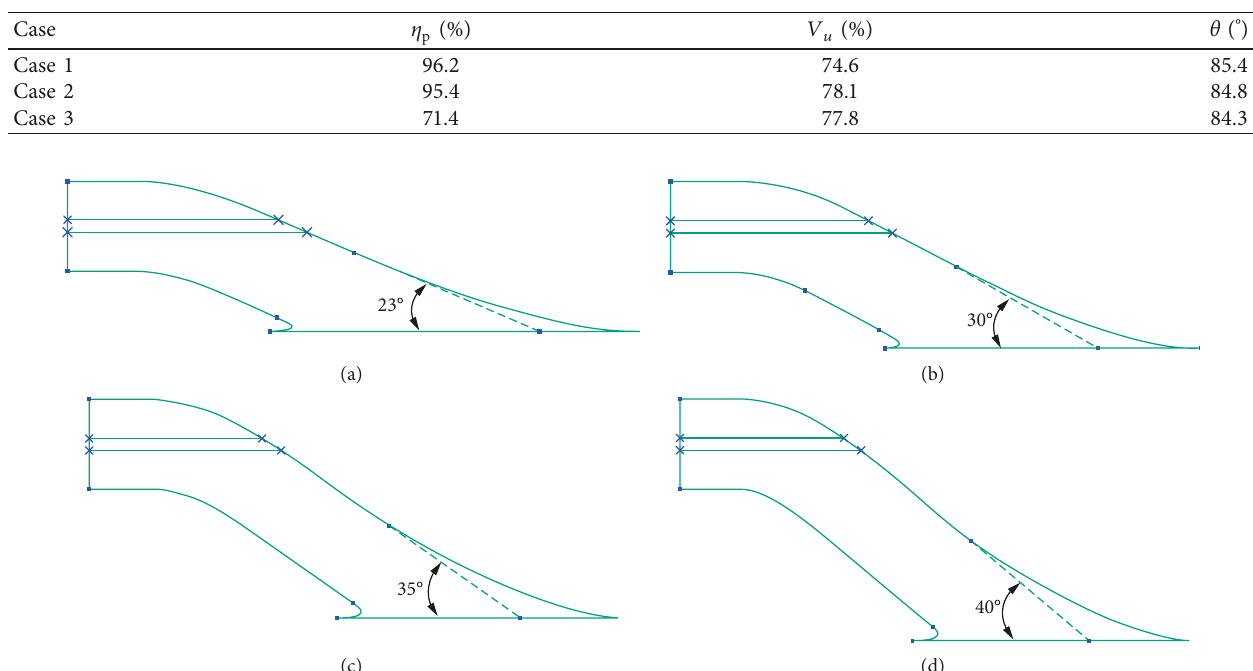
Figure 22: Sketch of the dip angle optimization cases. (a) Case 4 (b) Case 5. (c) Case 6. (d) Case 7.